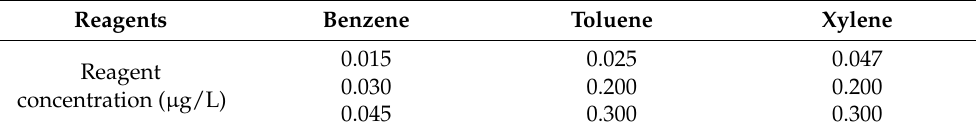
Table 2. BTX concentrations used in cell culture media on cell